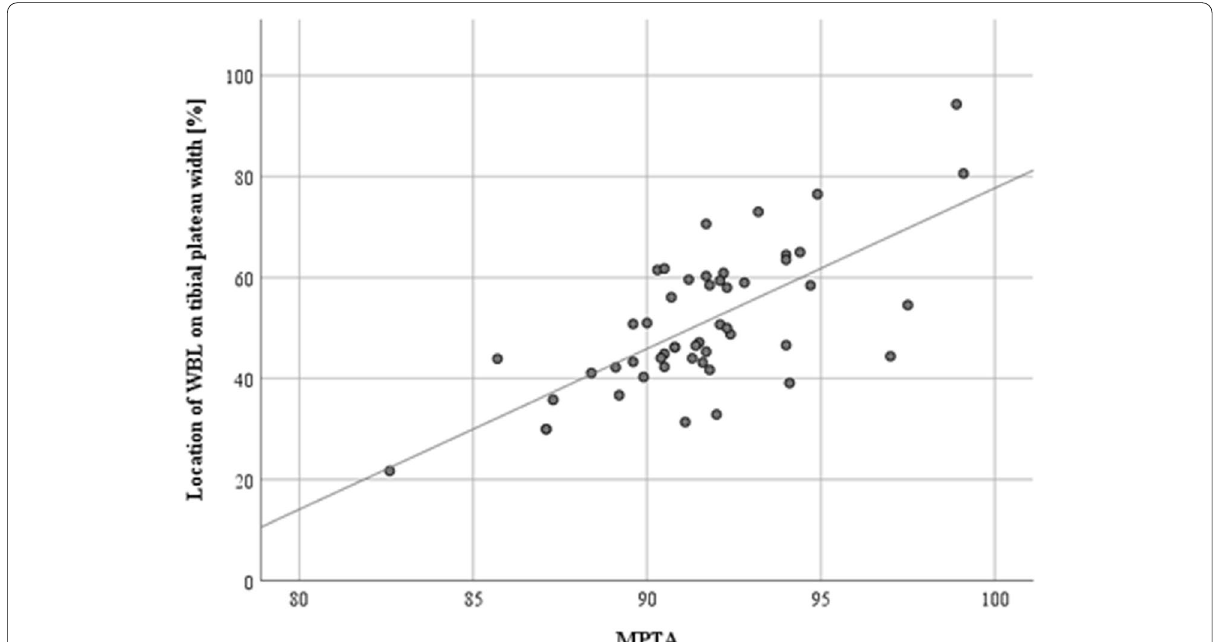
Fig. 3 Linear regression analysis showed a statistically significant correlation of the postoperative medial proximal tibial angle (MPTA) and the postoperative location of the WBL on the tibial plateau width ratio. An increase of the MPTA by one degree will lead to lateral shift of the WBL